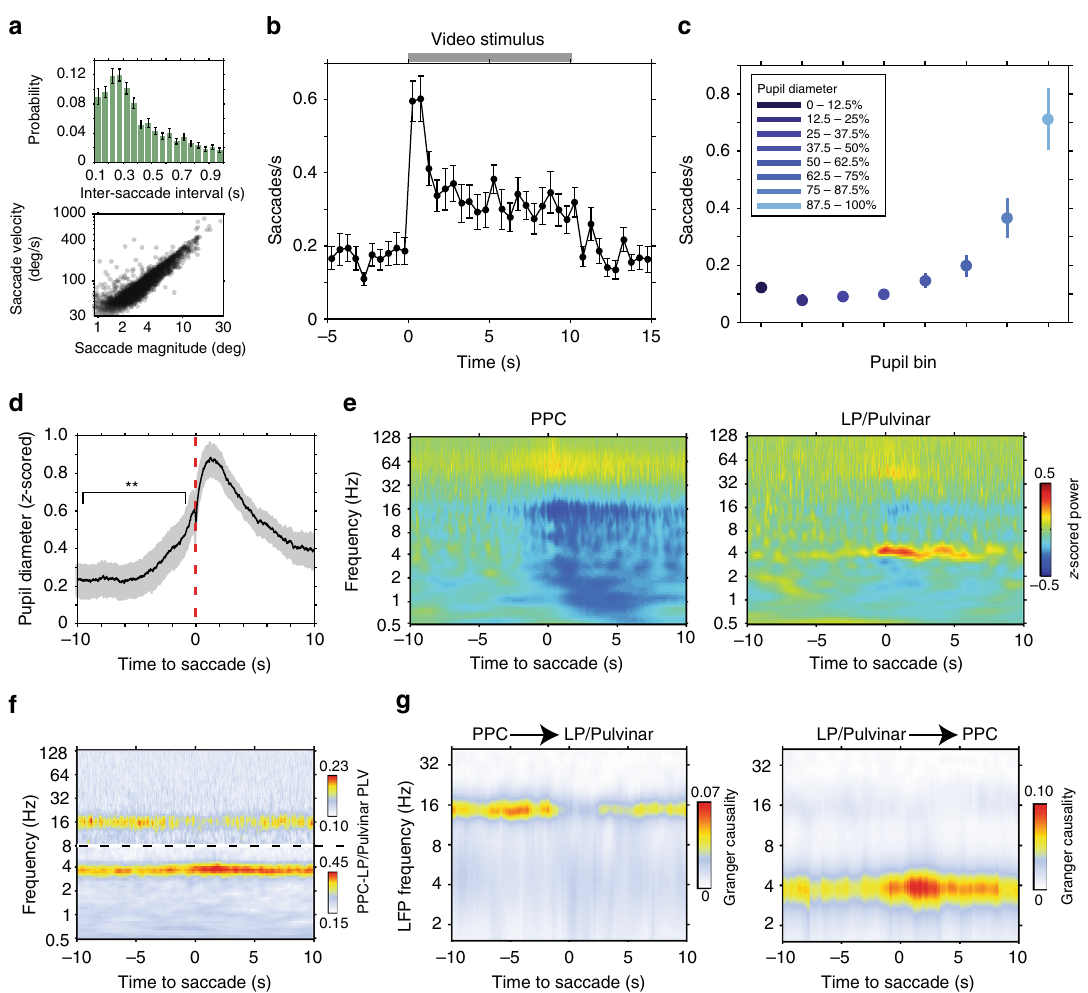
Fig. 6 Saccades link visual sensory processing and pupil-linked arousal-related changes in thalamo-cortical dynamics. a Distribution of inter saccade interval (top, ±SEM) shows that ferrets actively sample the visual environment rhythmically. The relationship between saccade magnitude and peak velocity (bottom) re fl ects the ballistic nature of saccades in ferrets. b Saccade rate during naturalistic video presentation illustrates that animals actively sample visual stimuli by showing an elevated rate of saccades ( n = 26 sessions). c Saccade rate as a function of pupil diameter in the dark. The rate of saccades during large pupil diameter states is comparable to the rate of saccades when animals are actively sampling naturalistic videos. d Mean (±SEM) fl uctuations in pupil diameter time locked to saccadic eye movements in the dark. Transient increases in pupil diameter precede saccades ( P = 0.004, t -test). e Population average LFP power spectrograms in PPC (left) and LP/Pulvinar (right) time locked to saccades in the dark. LFP power was z -score normalized across the entire recording session. f Population average PPC to LP/Pulvinar PLV time locked to saccades in the dark. Dotted line indicates a break in the color scale, as shown to the right of the fi gure. g Across-session average time and frequency resolved Granger causality between PPC and LP/Pulvinar around the occurrence of saccades in the dark. Active sampling by saccades was associated with a decrease in PPC causal in fl uence on LP/Pulvinar in the alpha band and an increase in LP/Pulvinar on PPC in the theta